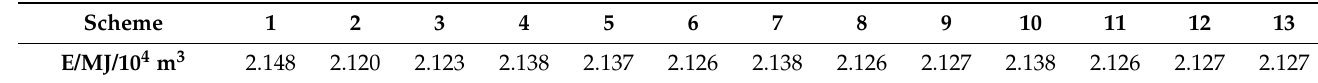
Table 11. Evaluation parameter E